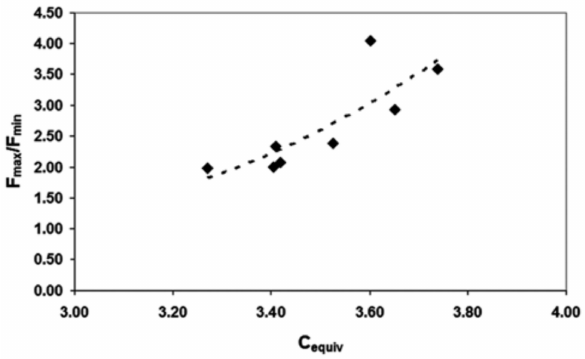
Figure 6. Relationship between the equivalent carbon and the graphite morphology given by the Feret diameter